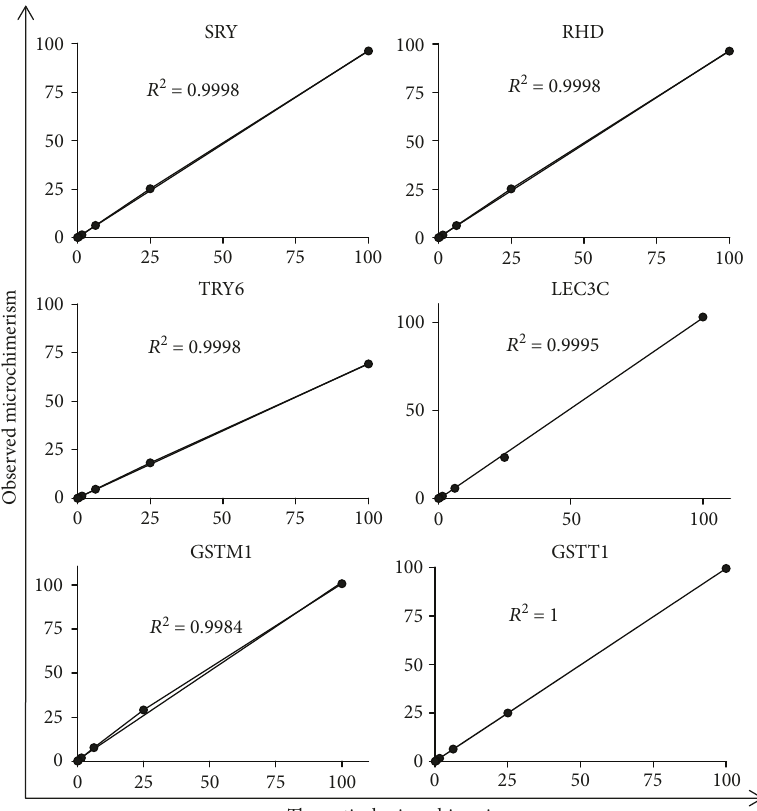
Figure 1: Demonstration of ddPCR linearity for the various genes tested. Donor DNA was serially diluted and used in a ddPCR assay for SRY, RHD, TRY6, LEC3C, GSTM1, and GSTT1. The percentages of chimerism obtained (observed microchimerism) were plotted against the expected values (theoretical microchimerism) and the regression coe ffi cient ( R 2 )